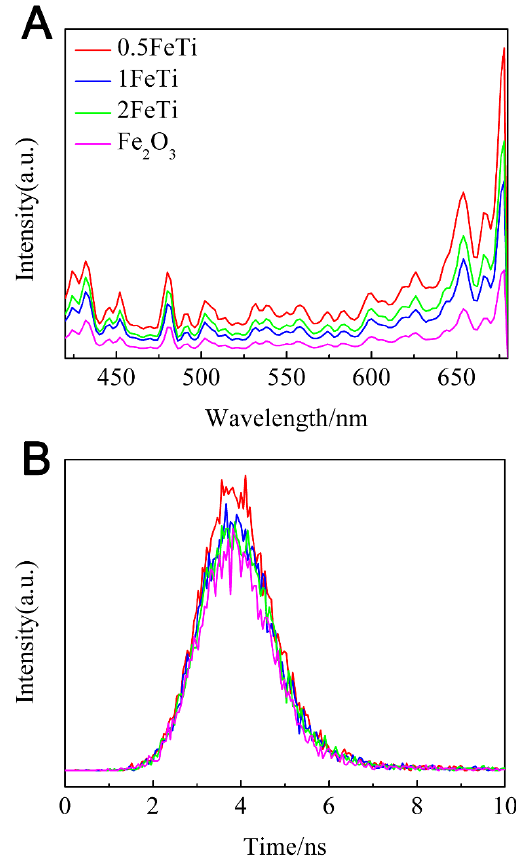
Figure 6. ( A ) PL spectra of 0.5FeTi, 1FeTi, 2FeTi, and Fe 2 O 3 ; ( B ) Decay curves of 0.5FeTi, 1FeTi, 2FeTi, and Fe 2 O 3 (excited at λ = 420 nm). and Fe λ = 420 2 O 3 (excited at